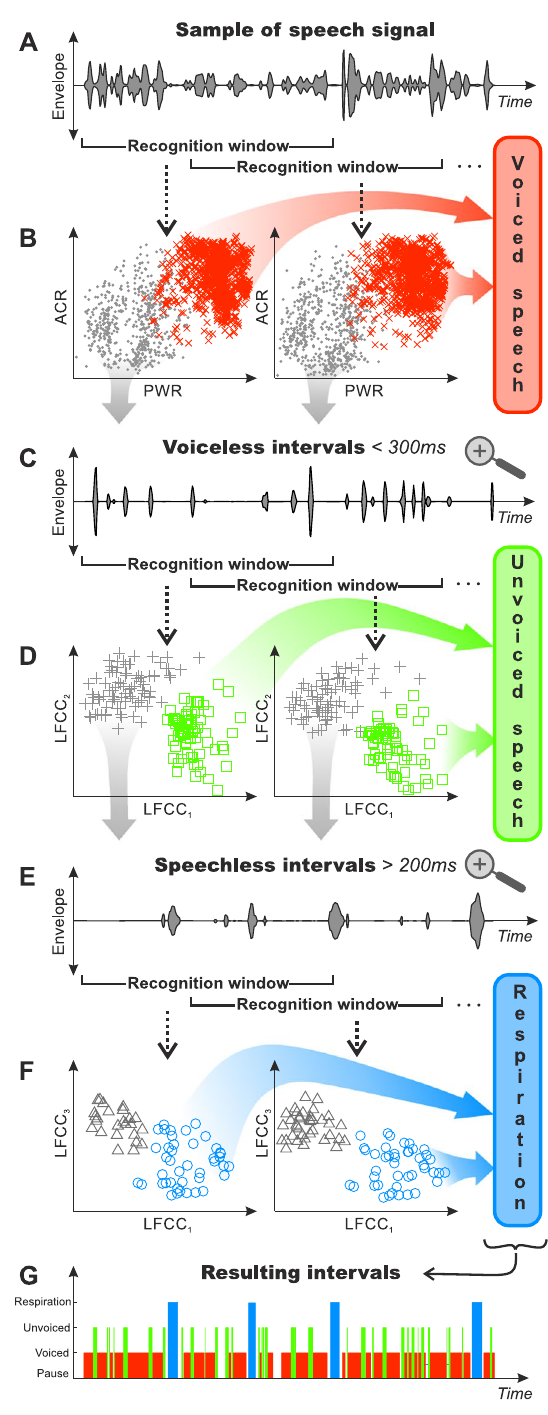
Figure 1. Process diagram illustrating the principle of the automated segmentation algorithm on a speech signal sample. ( A ) Original speech sample depicted using oscillographic sound pressure plot. ( B ) Red ‘x’ marks illustrate recognized voiced speech depicted in dimensions of PWR and ACR in two consecutive recognition windows. ( C ) Speech sample representing voiceless intervals shorter than 300 ms after removal of voiced intervals from original speech sample. ( D ) Green ‘o’ marks illustrate recognized unvoiced speech depicted in dimensions of the first linear-frequency cepstral coefficient (LFCC 1 ) and the second linear-frequency cepstral coefficient (LFCC 2 ) in two consecutive recognition windows. ( E ) Speech sample representing respiration intervals longer than 200 ms after removal of voiced and unvoiced intervals from original speech sample. ( F ) Blue ‘o’ marks illustrate recognized respirations depicted in dimensions of the first linear-frequency cepstral coefficient (LFCC 1 ) and the third linear-frequency cepstral coefficient (LFCC 3 ) in two consecutive recognition windows. ( G ) Resulting intervals of the segmentation plotted in time. PWR = power, ACR = variance of autocorrelation